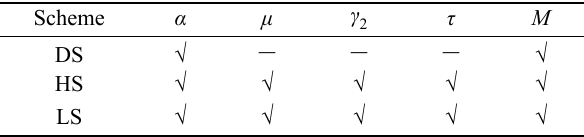
Table 2 Key parameters for DABC with different search schemes. Scheme